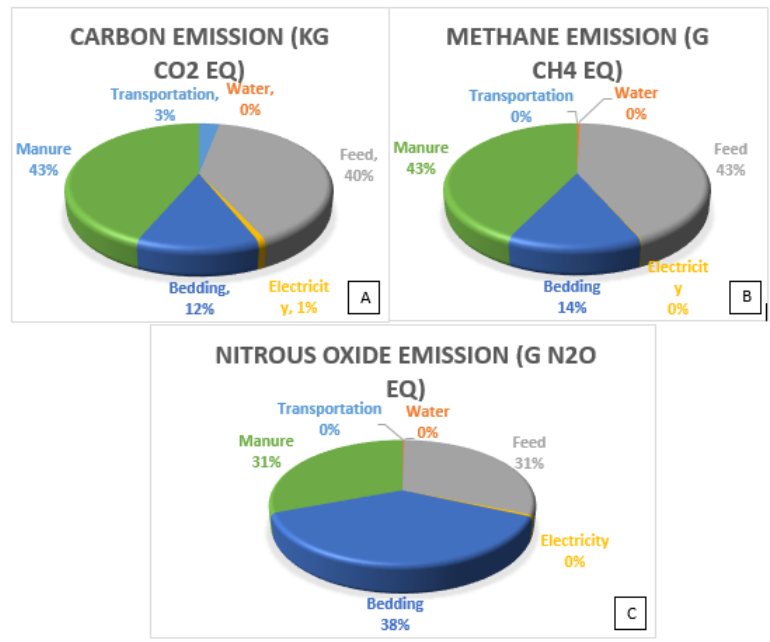
Figure 7: Results of GHG emission; a) carbon emission b) methane emission c) nitrous oxide emission